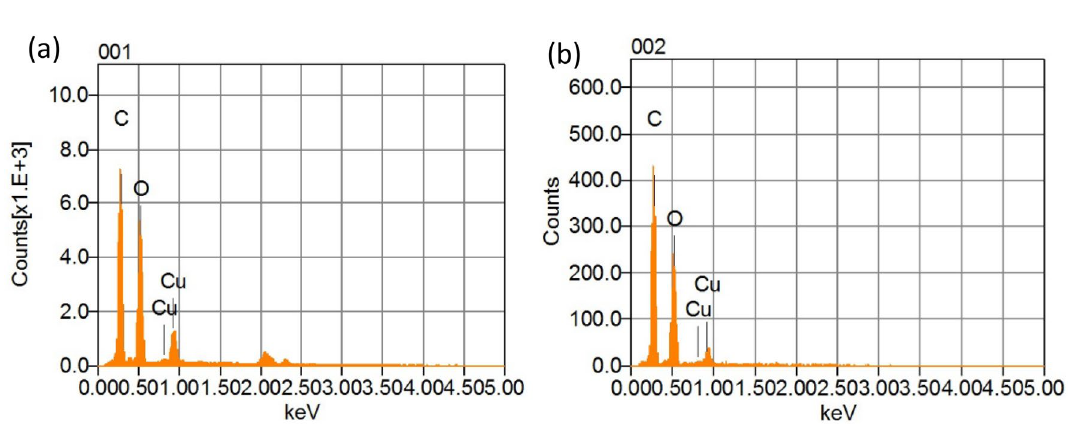
Figure 2. EDX spectra of ( a ) CuO NPs-1 and ( b ) CuO